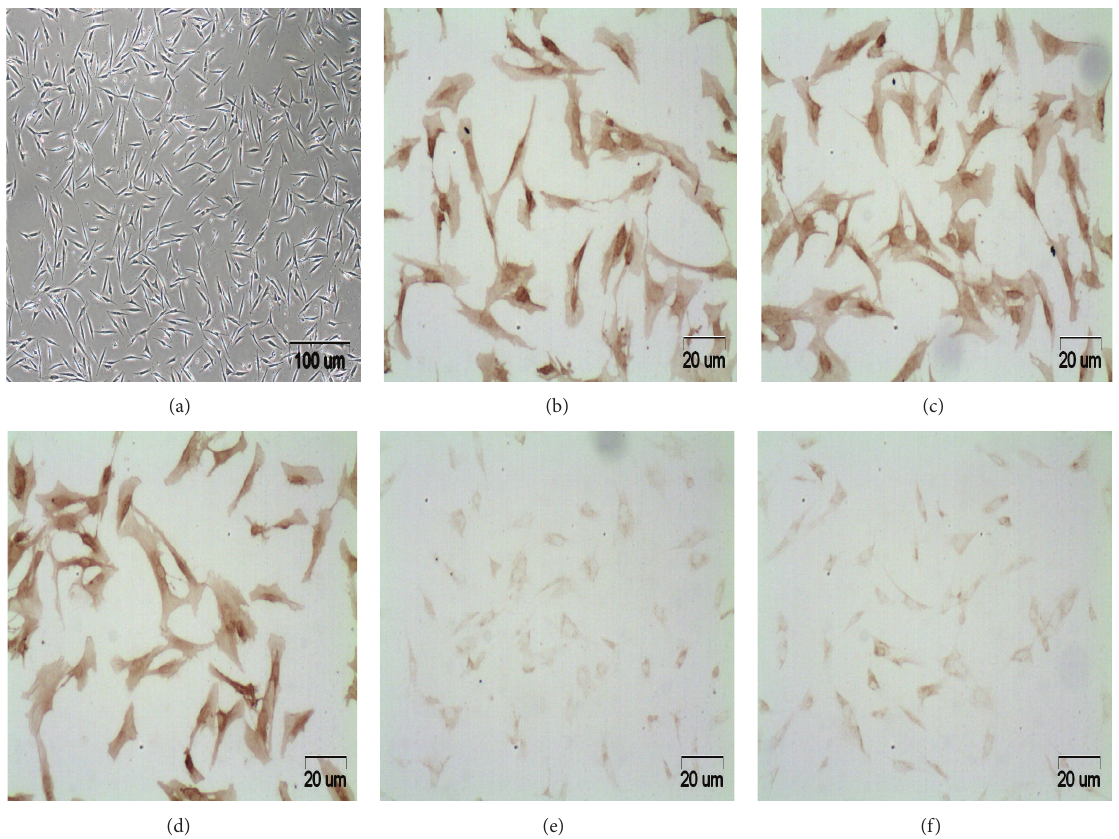
Figure 1: Photomicrographs of primary culture ASCs ((a), magnification × 40) and mesenchymal stem cell characteristics identified by CD29, CD44, and CD105 positive, respectively ((b)–(d), magnification × 200) and hemopoietic lineage markers CD34 and CD45 negative ((e) and (f), magnification × 200) using immunohistochemistry.